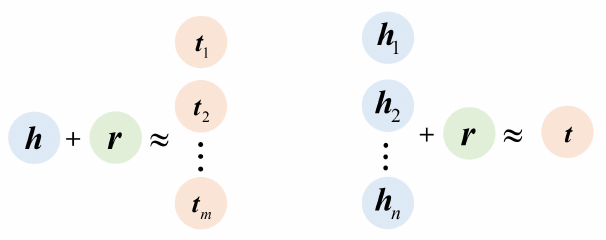
Figure 2. Example of complex relationships. The left side is the 1‑to‑N relationship type, the right side is the N‑to‑1 relationship